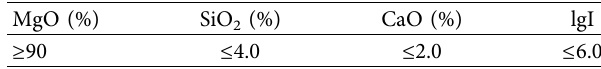
Table 2: Chemical components of MgO.